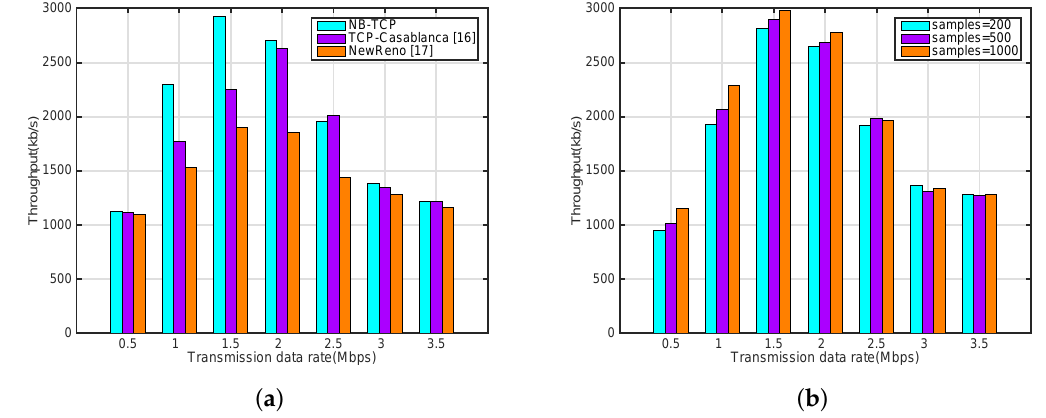
Figure 7. Throughput versus transmission data rate ( a ) Method comparison ( b ) Different sample